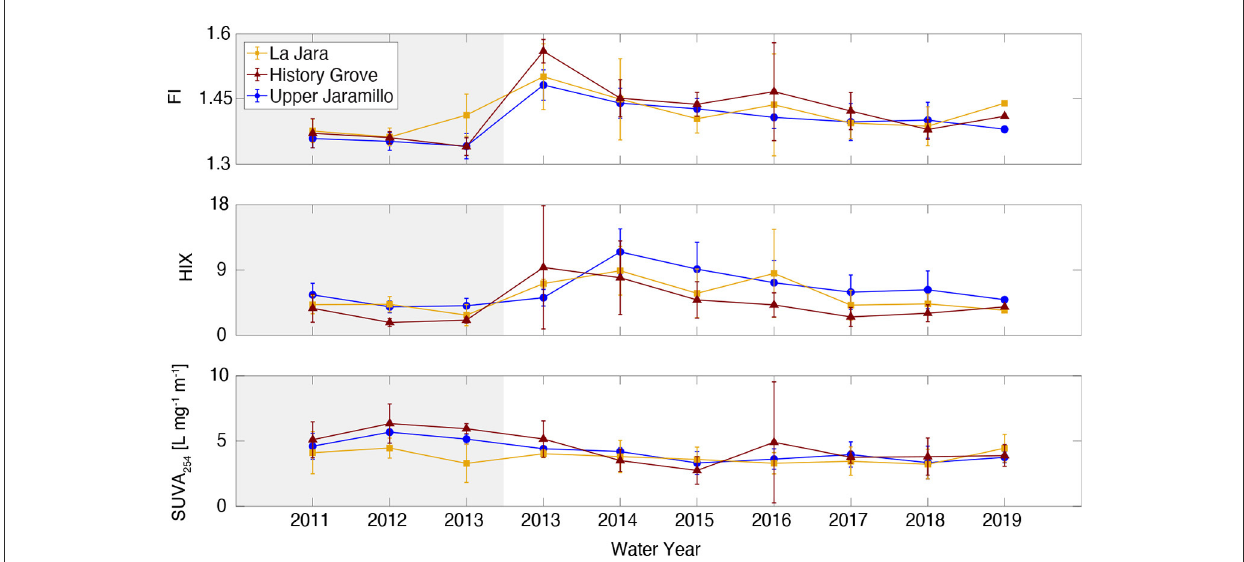
FIGURE7 Annual volume-weighted means (VWM) of the fluorescence Index (FI), humification index (HIX) and specific UV absorbance at 245nm (SUVA254), from La Jara, History Grove, and Upper Jaramillo catchments. Notice that for the WY 2013 there are two calculated fluxes—before and after the Thompson Ridge Wildfire in the summer of 2013—in order to illustrate the immediate effect of the fire in the three headwater catchments.